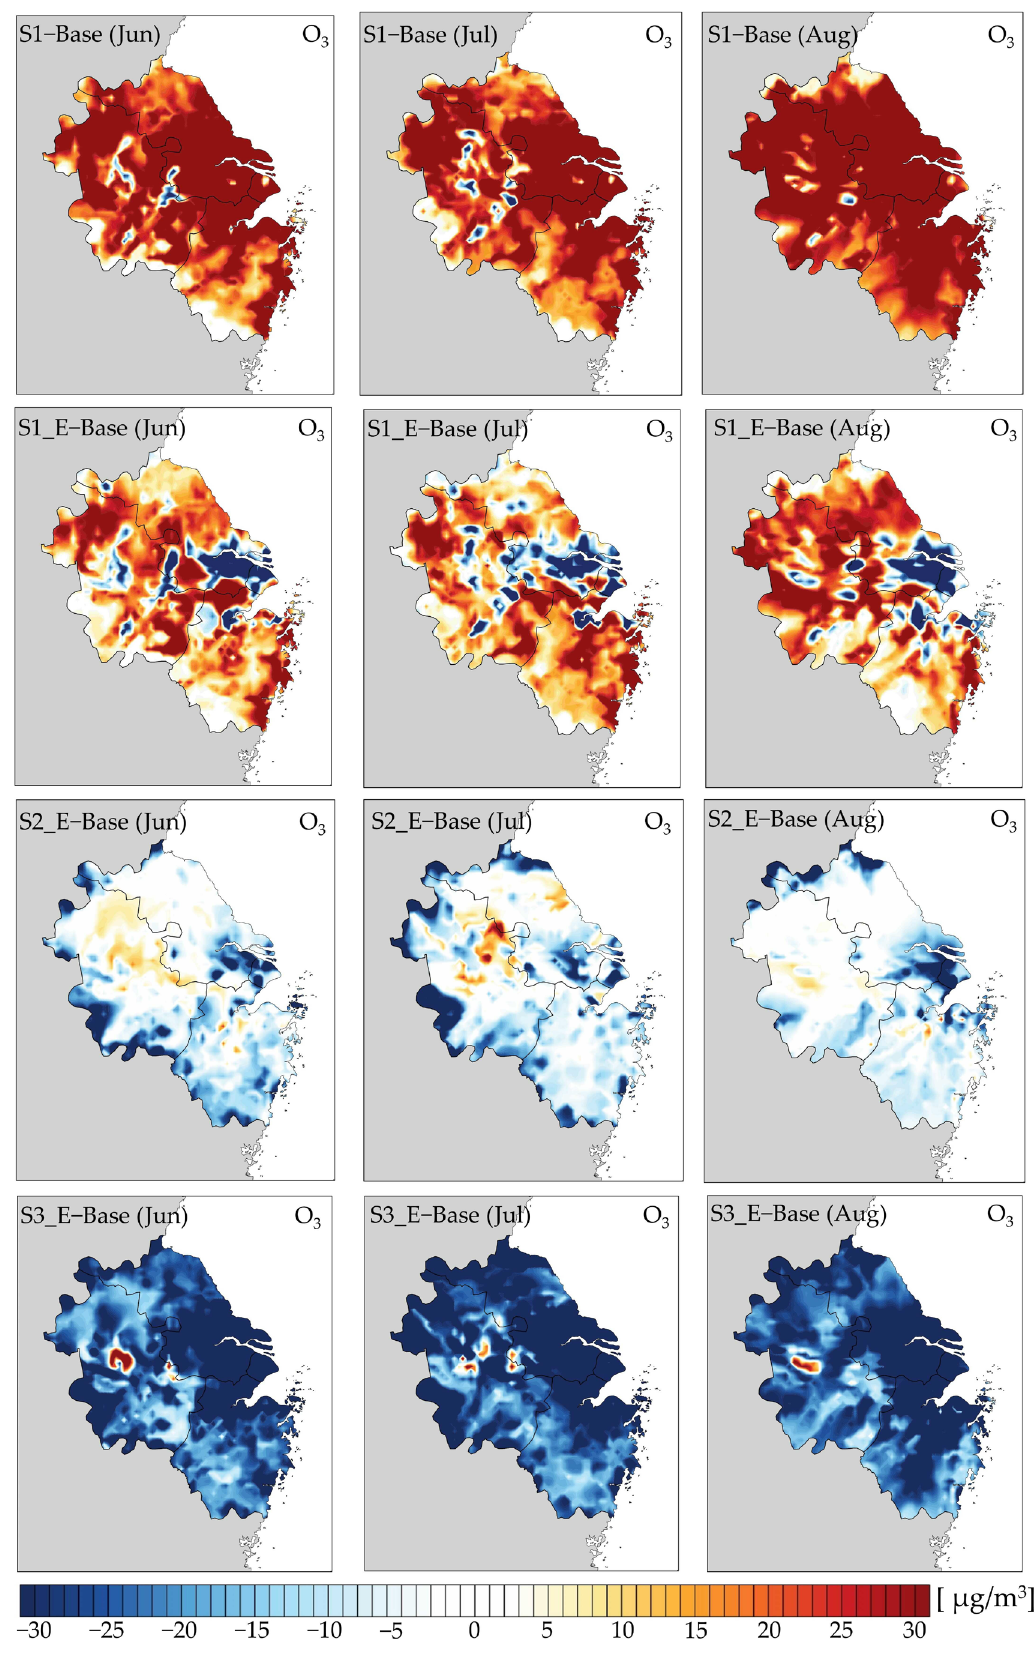
Figure 5. Spatial distributions of MDA8 O 3 concentration change values under the 4 control scenarios relative to the base case over the YRD region in June (Jun), July (Jul) and August (Aug), 2025.